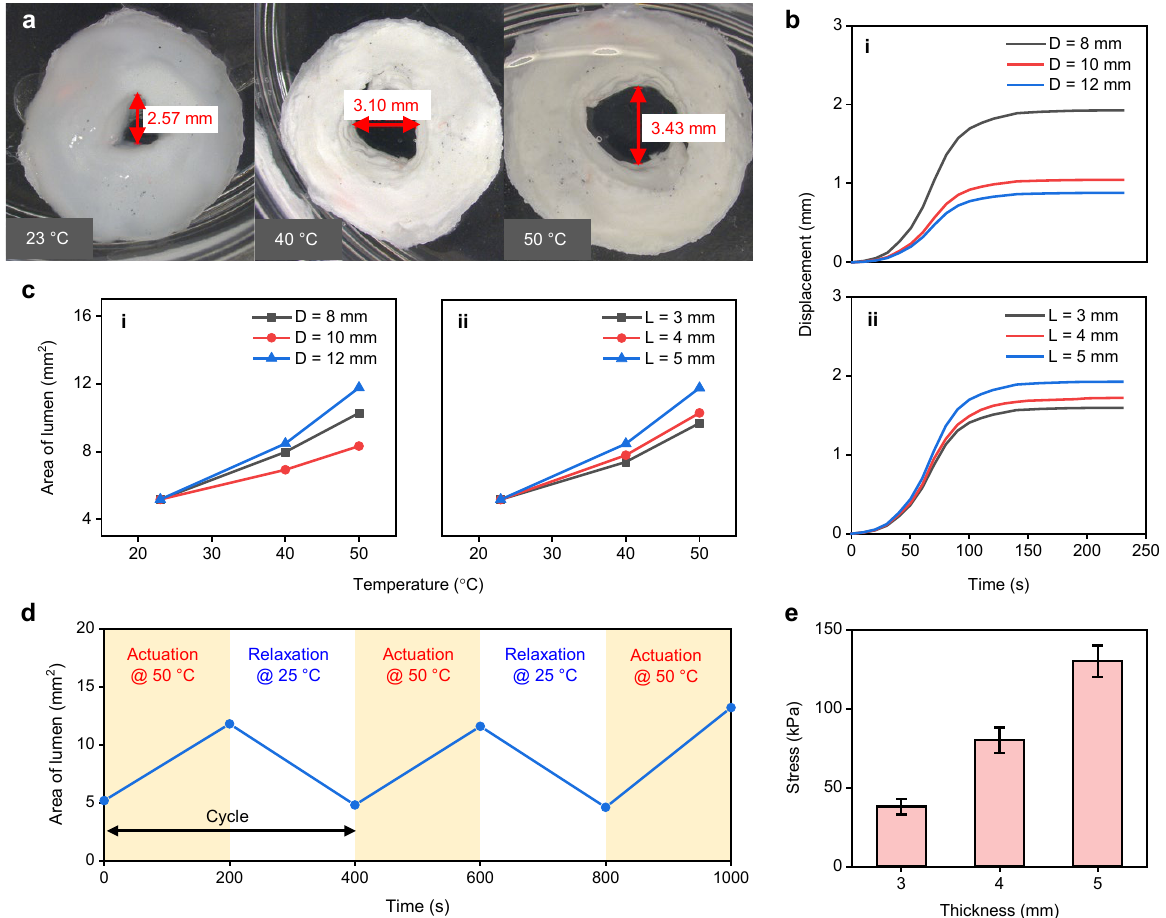
Figure 4. Thermo-mechanical performance of NPHVs. ( a ) Optical microscopy images showing the displacement of NPHV when actuated at 40 and 50 ◦ C. ( b ) (i) Displacement in NPHVs ( L = 5 mm) with different diameters ( D = 8–12 mm) when actuated at 40 ◦ C for 230 s. (ii) Displacement in NPHVs ( D = 8 mm) with different thicknesses ( L = 3–5 mm) when actuated at 40 ◦ C for 230 s. ( c ) (i) Changes in NPHV lumen area ( L = 5 mm) for different diameters ( D = 8–12 mm) when actuated at 40 and 50 ◦ C. (ii) Changes in NPHV lumen area ( D = 12 mm) for different thicknesses ( L = 3–5 mm) when actuated at 40 and 50 ◦ C. ( d ) NPHVs’ lumen area change ( D = 12 mm, L = 5 mm) over three cycles actuated at 50 ◦ C. ( e ) NPHVs’ compressive strength at different thicknesses ( L = 3, 4, and 5